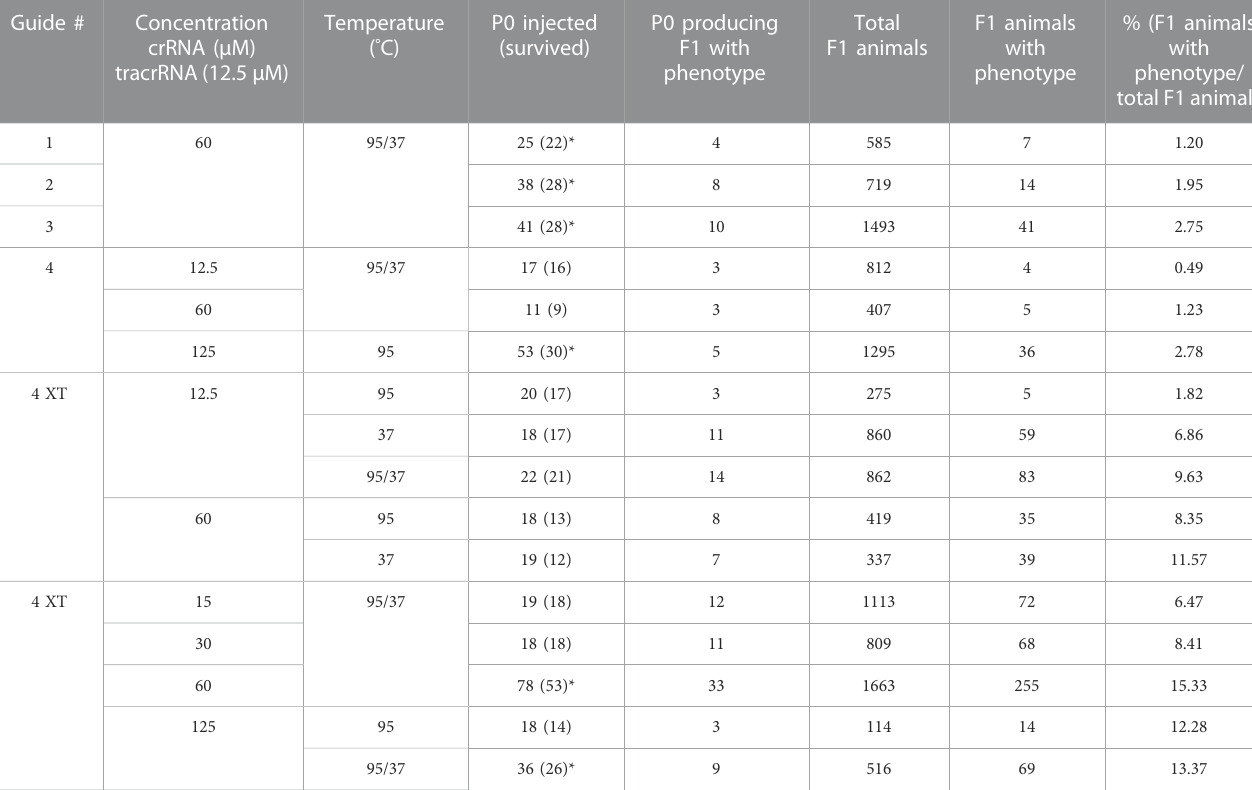
TABLE 3 Summary of CRISPR/Cas9 experiments targeting the PS1159 unc-22 gene. Guide